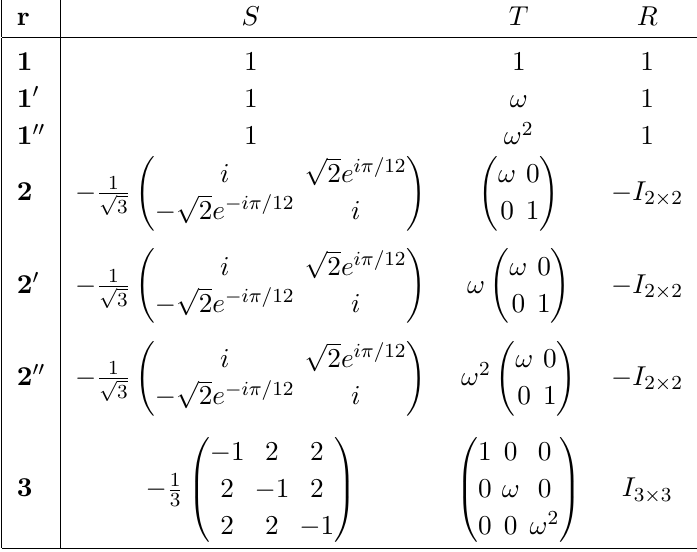
Table 7. The matrix representations of S and T . ω = e 2 πi/ 3 . Our notation is based on [31]. Γ 0 is isomorphic to T 0 . T 0 has seven irreducible 3